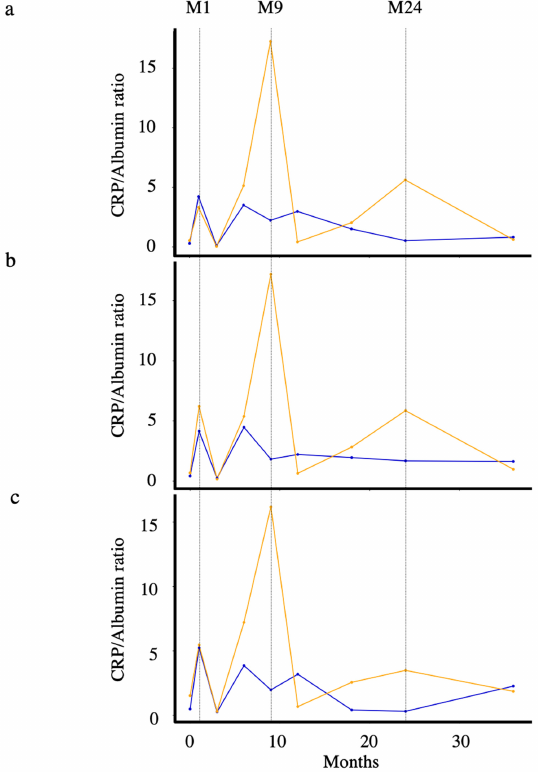
Figure A2. Blue: cluster A. Orange: cluster B. ( a ): Longitudinal trajectory clustering of the CAR among elderly outpatients with breast cancer. The median CARs for clusters A and B was respectively: 0.09 [0.02–0.21] and 0.09 [0.02–0.50] at baseline, and 0.11 [0.01–3.17] and 0.19 [0.02–5.97] during the study follow-up. ( b ): Longitudinal trajectory of the CAR among elderly outpatients with colorectal cancer. The median CARs for clusters A and B was respectively: 0.16 [0.04–0.41] and 0.27 [0.11–0.75] at baseline, and 0.20 [0.02–3.60] and 1.10 [0.07–6.62] during the study follow-up. ( c ): Longitudinal trajectory of the CAR among elderly outpatients with lung cancer. The median CARs for clusters A and B was respectively: 0.24 [0.08–0.58] and 0.62 [0.31–1.62] at baseline, and 0.23 [0.04–3.14] and 2.30 [0.09–6.36] during the study follow-up.